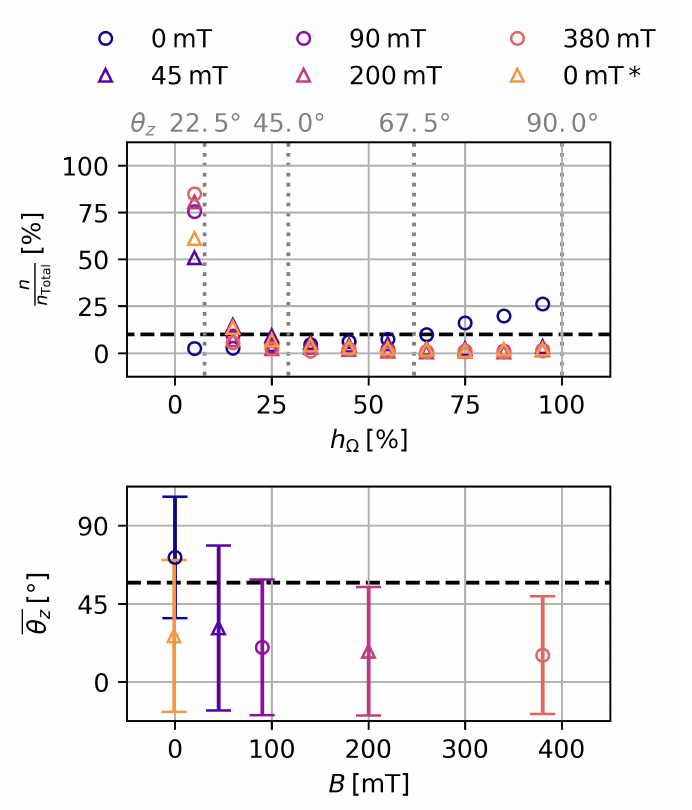
Figure 4. Distribution of the solid angle represented by the relative height of the spherical segment h Ω and the average z -angle θ z over the magnetic flux density. Data are shown for a sample with w s = 10% at c NaCl = 0molL − 1 . The expected value of 10%, the average z -angle θ z = 57° for an equal solid angle distribution of the particles as well as some z -angles θ z are shown for orientation.